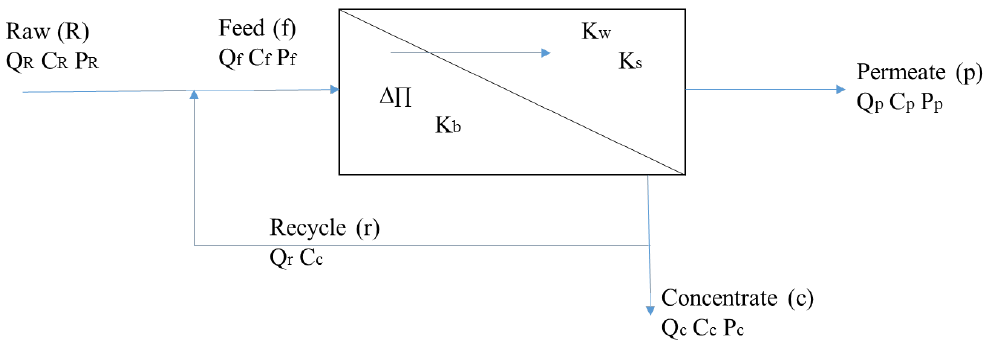
Figure 5. Single membrane element mass balance diagram.